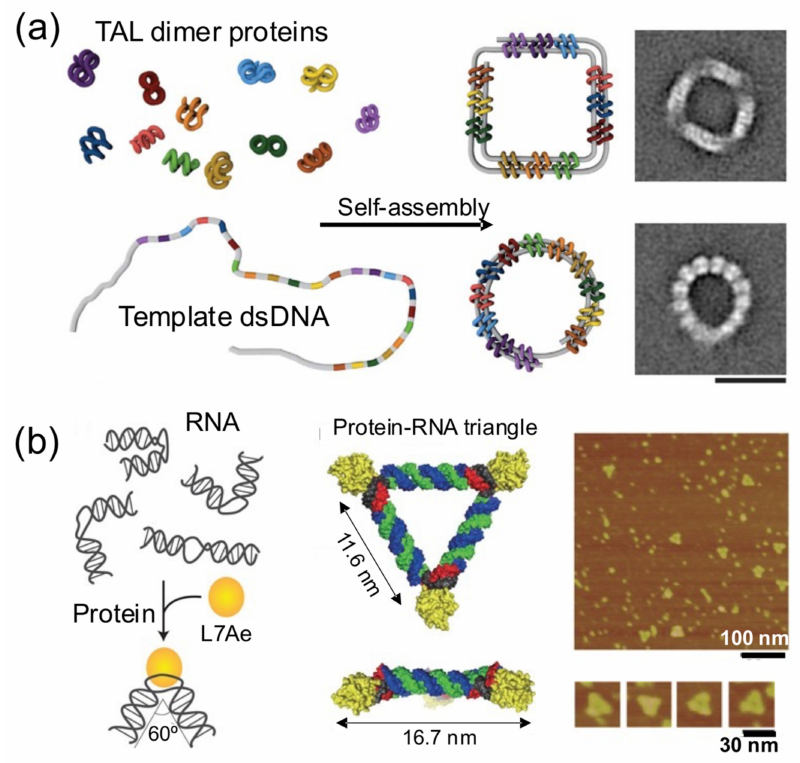
Figure 6. DNA is shaped by proteins into nanostructures. ( a ) Dimeric TAL effectors were pro- grammed to attach to a dsDNA molecule in specific positions and fold it into predesigned hybrid nanostructures (left). TEM image (right). Scale bar: 20 nm. Reproduced from [17], with permission from AAAS, 2017. ( b ) An equilateral triangle is formed by bending RNA by RNA-binding protein L7Ae (left). AFM image (right). Adapted from [32], with permission from Springer Nature,